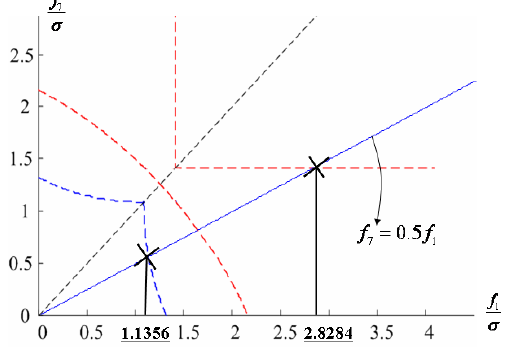
Figure 22. Accommodation rule for 1 st and 7 th faulty sensors in Figure